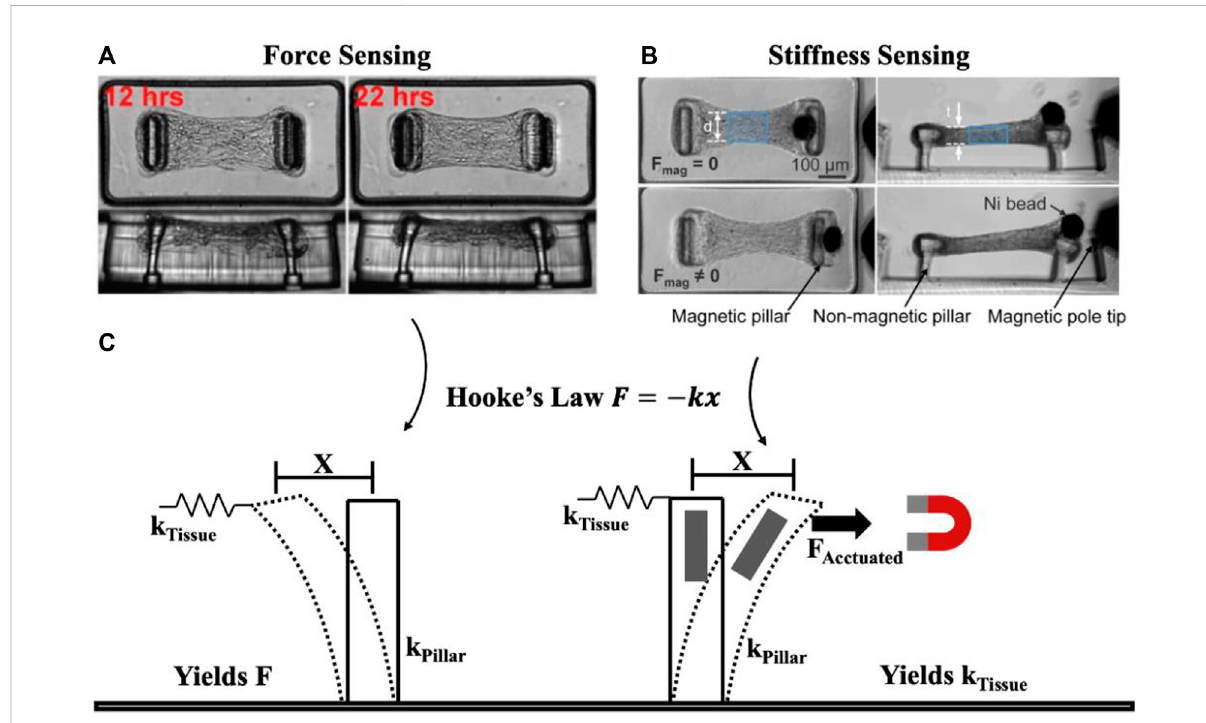
FIGURE 1 Simpli fi edviewofunderlyingprinciplebehindforceandmechanicalproperty(e.g.,stiffness)measurement.Tissueforcesensing (A) andstiffness sensing (B) are both possible using micropillars. Considering pillars to behave as springs, force is measured based on pillar deformation x and pillar springconstant k Pillar toyieldforce F ,whilestiffnessismeasuredbypillardeformation x asaresultofappliedforce F Actuated toyieldthespringconstant k Tissue (C) . Essentially, mechanical property measurement requires a form of actuation unlike force sensing. (A) Representative time course imaging of a contracting microtissue. Reprinted with permission from Legant et al. (2009), Proc. Natl. Acad. Sci. 106(25). 10097-10102 (2009). (B) Microtissue before ( F mag = 0) and after ( F mag ≠ 0) magnetic force is applied to stretch the tissue. Reprinted with permission from Zhao et al.